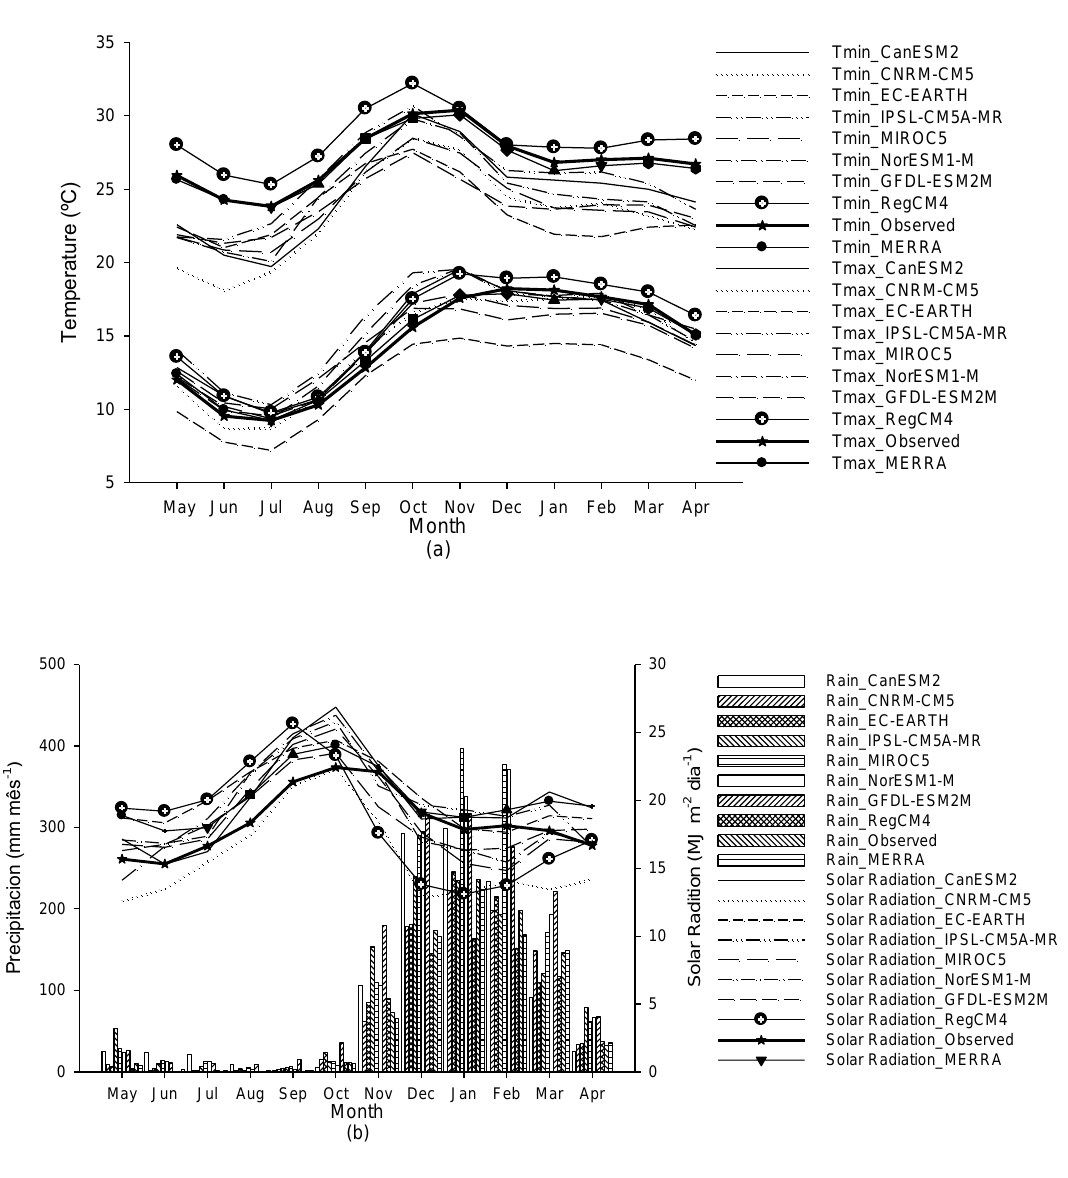
Figure 2. ( a ) monthly maximum and minimum average temperatures and ( b ) monthly averaged precipitation and solar radiation in Angónia, Mozambique, for the period 1980–2010 for CORDEX models, MERRA reanalysis, and observations, and for 1990–2010 estimated by the RegCM4.